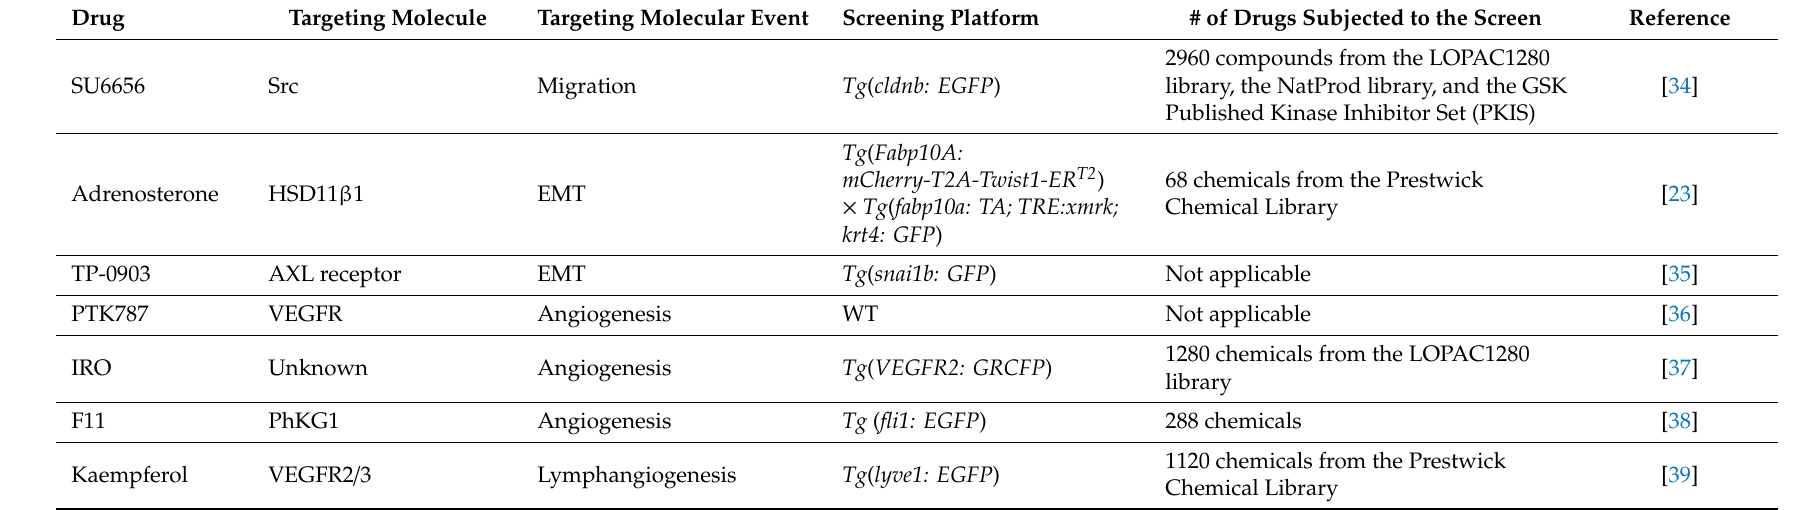
Table 2. A list of the anti-metastatic drugs identified through phenotype-based screening using